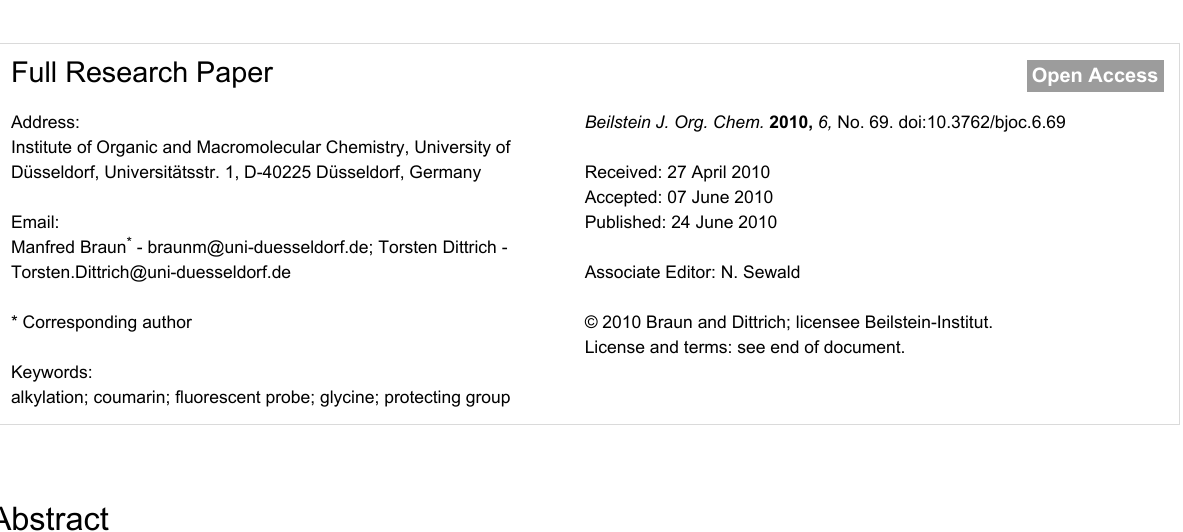
reversed-phase HPLC. Unfortunately, this procedure, despite the elegant concept of the synthetic route, is not applicable for the provision of larger quantities of product. As a result we were interested in developing an alternative route to racemic amino acid 1